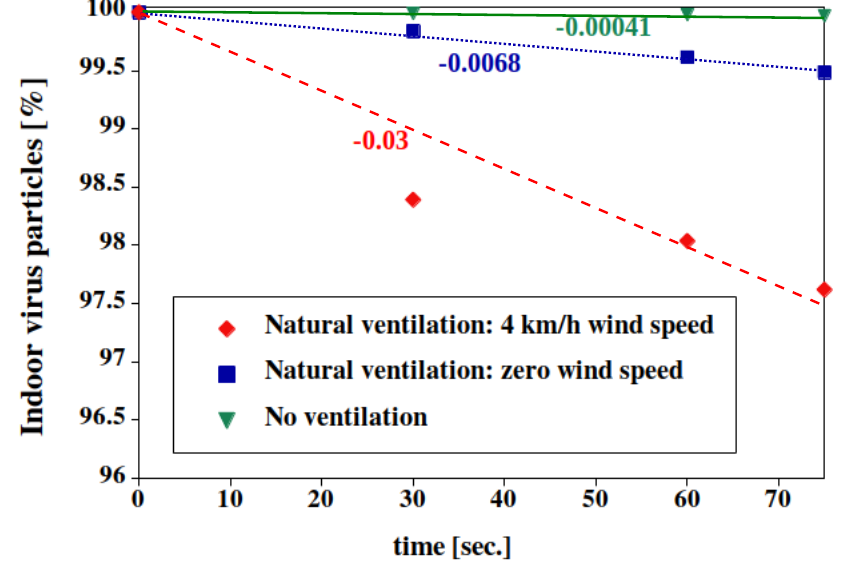
Figure 9. The percentage of aerosol pollutant particles remaining in the room as a function of time. A dashed line with diamond symbols: Case of natural ventilation due to thermal convection at low outdoor wind speed U y = 4 km/h (slope = − 0.03). The dotted line with square symbols: Case of natural ventilation due to thermal convection at negligible outdoor wind speed U = 0 (slope = − 0.0068). Solid line with triangle symbols: Without natural ventilation, particles settle due to gravitational forces (slope = − 0.00041). Walls-particles-interaction: unstick (worst case scenario of aerosol particles